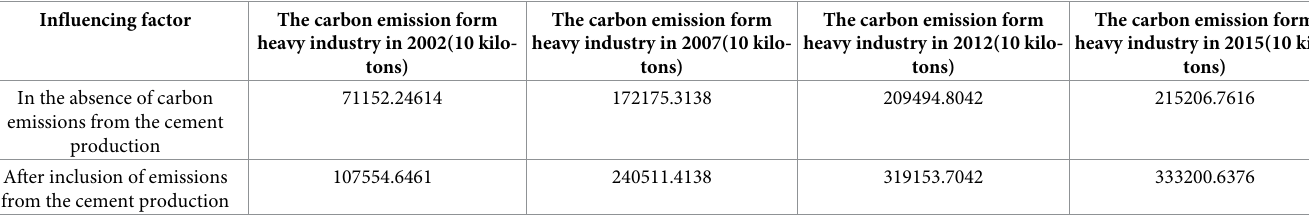
Table 8. The annual carbon emissions in heavy industry. Influencing